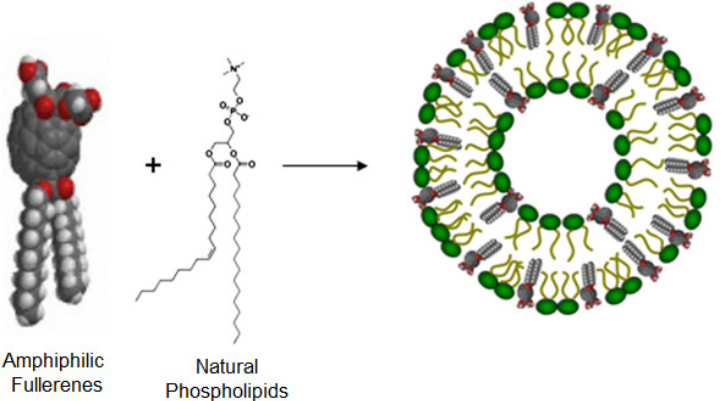
Figure 3. Vesicle formation of amphiphilic fullerene compound ALM with auxiliary phospholipids.